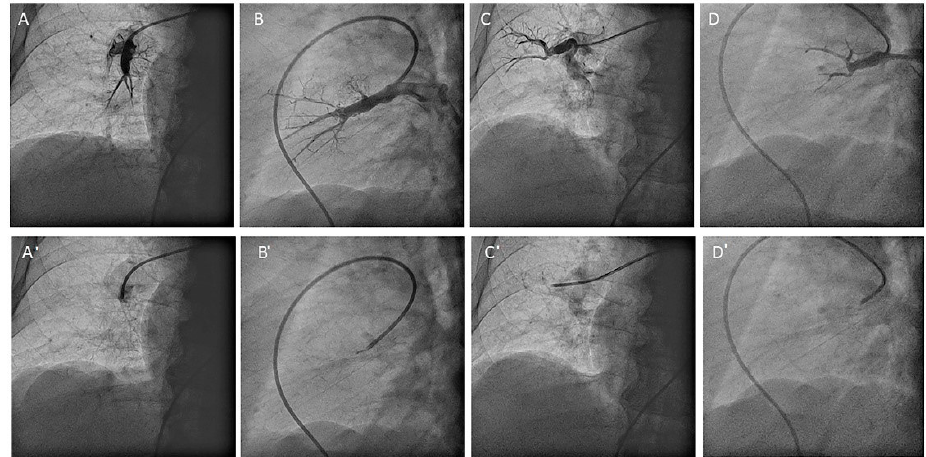
Figure 31. MP catheter canulating the ( A , B ) medial (A5) and ( C , D ) lateral (A4) middle lobe segmental branches. ( A , C ) Anteroposterior and ( B , D ) lateral views: ( A – D ) with contrast and ( A’ – D’ ) without contrast .